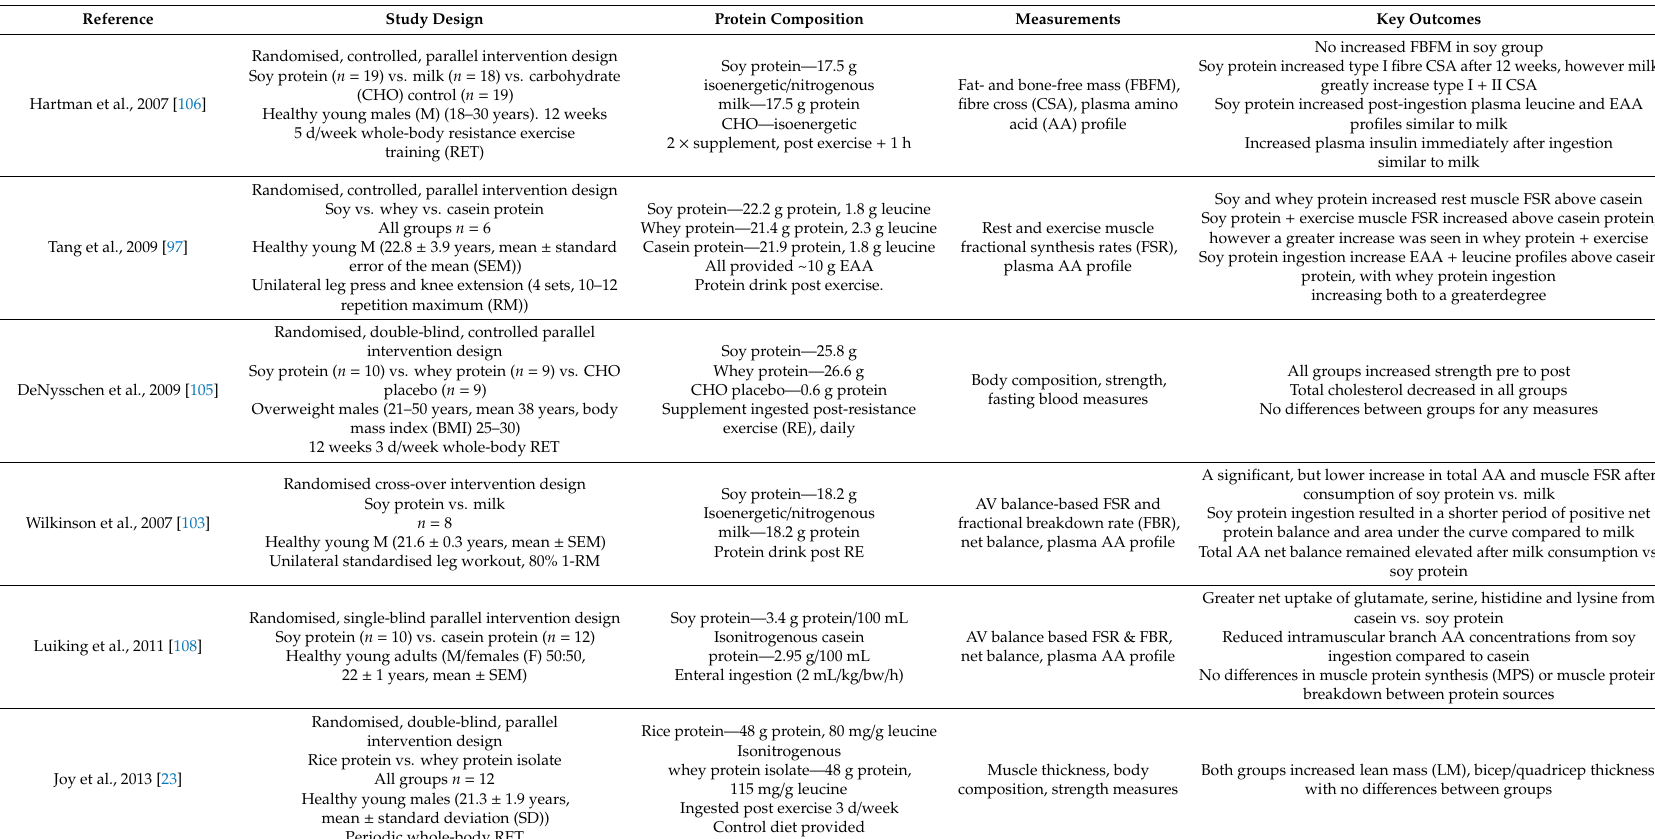
Table 3. Plant-derived proteins: e ff ects on muscle in relation to age, exercise, energy restriction and